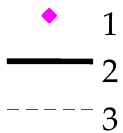
Figure 4. The energy balance of spongy moth females on pine: (1) hyperbola of optimal consumption; (2) data on caterpillars; (3) line of budgetary constraints.